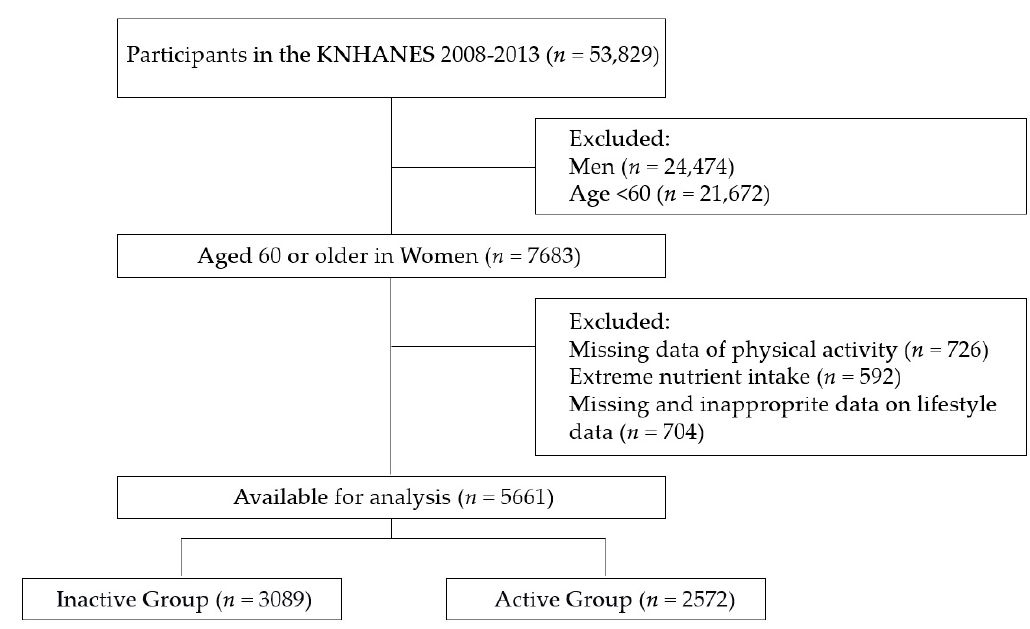
Figure 1. Study Figure 1. Study population.